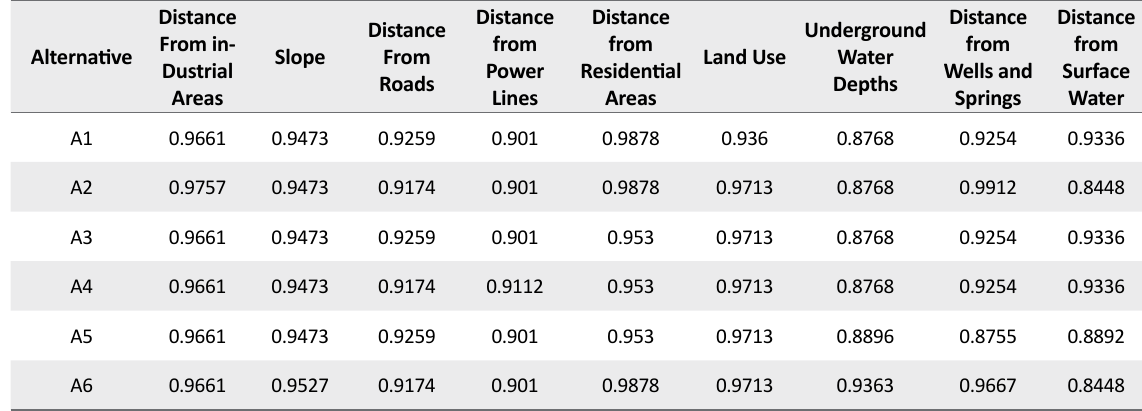
Table 10. Difference matrix between the normalized matrix points of fuzzy TOPSIS decision making and the positive ideal solution Distance From in - Alternative